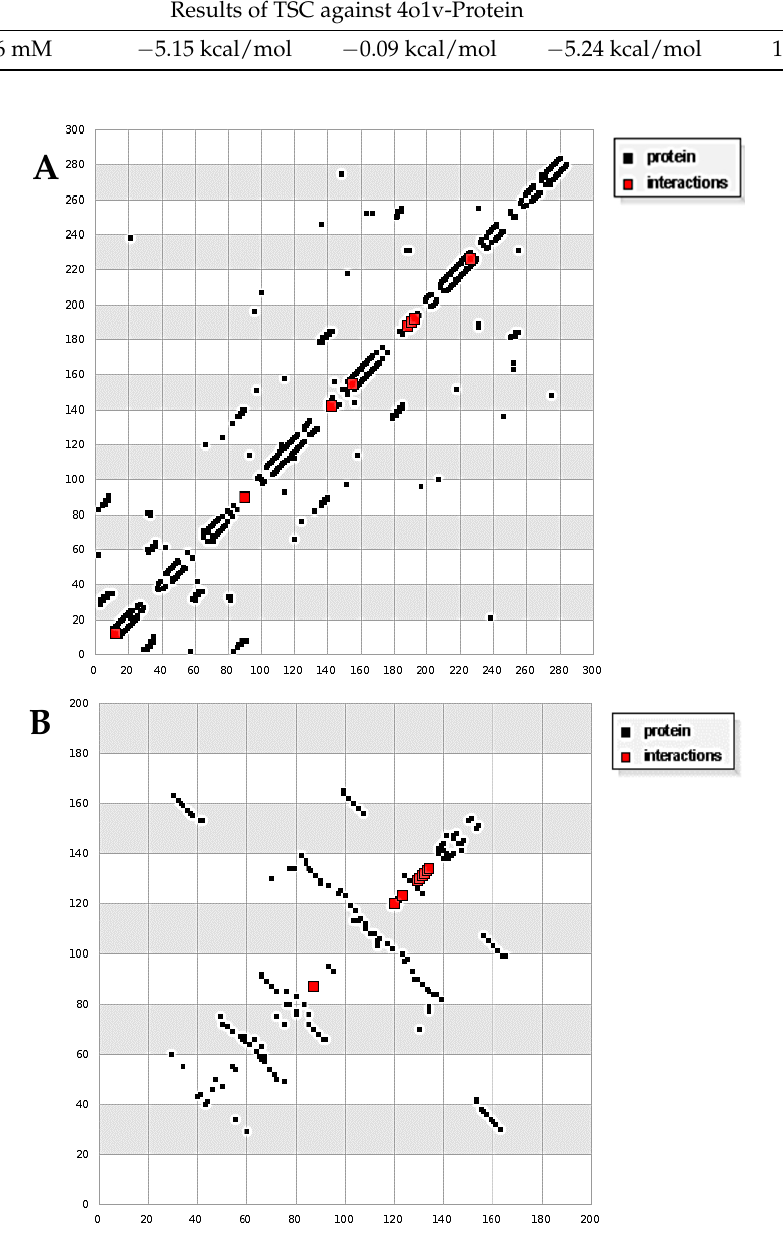
Figure 8. ( A ) HB plot of diim ligand against 3hb5 -oxidoreductase protein and ( B ) HB plot of diim ligand against 4o1v -protein binding.